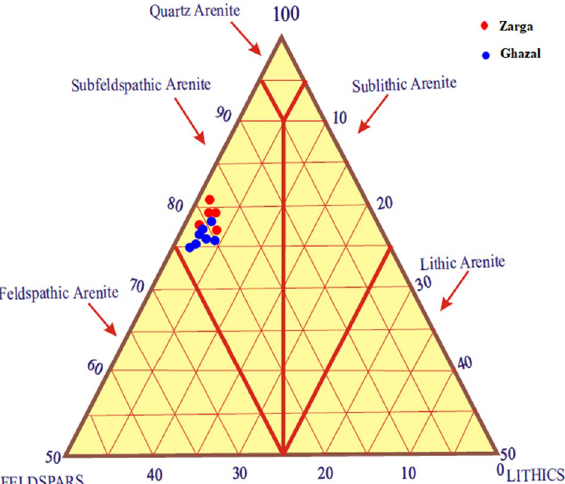
Figure 12. QFL Ternary Diagram for Sandstone Classification of the Zarga and Ghazal Formations sandstones (created from information in reference 33 ). QFL